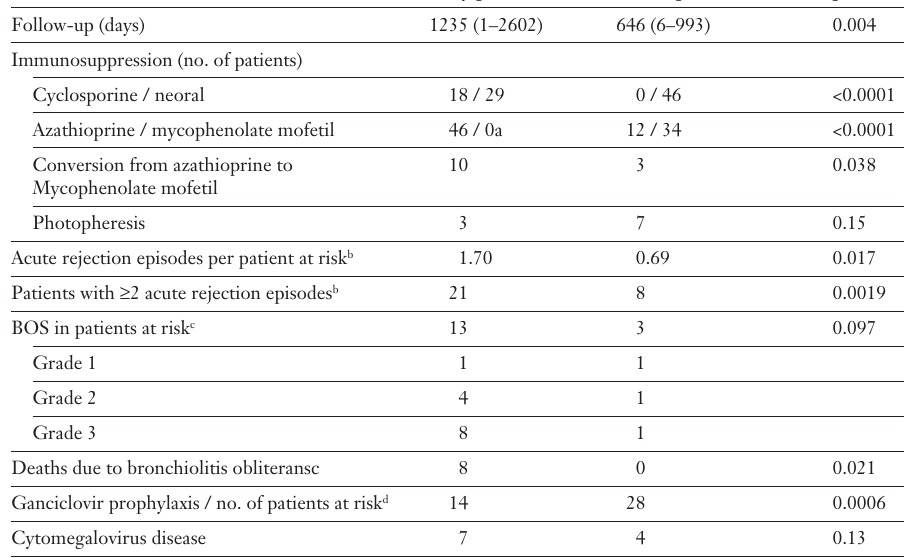
Treatment and outcome. Data are expressed as num- bers or medians, with ranges shown in parenthesis.